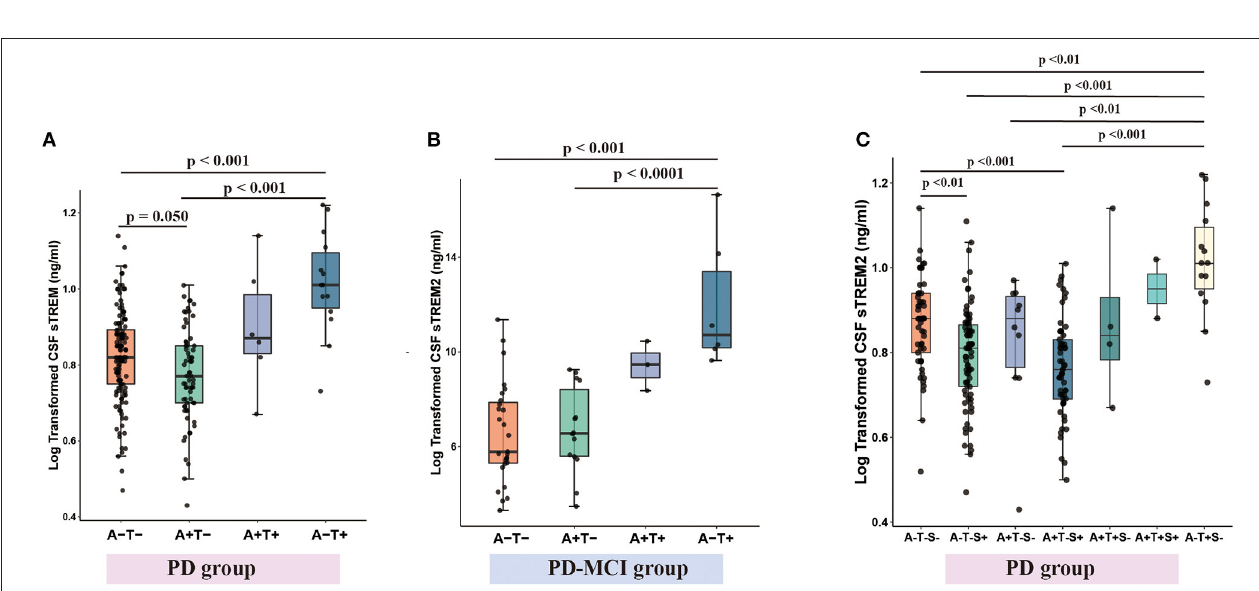
FIGURE 4 | Kaplan–Meier survival curve showed that higher baseline CSF sTREM2 was at a higher risk of cognitive impairment (log-rank p = 0.0059, (A) whereas the CSF sTREM2 changes did not predict a cognition decline in PD group during 7-year follow-up (log-rank p = 0.16, (B) . CSF, cerebrospinal fluid; sTREM2, soluble triggering receptors expressed on myeloid cells 2; PD, Parkinson’s disease.